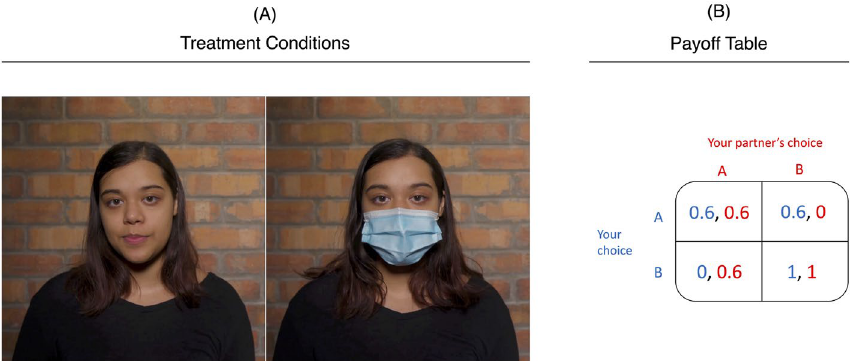
Figure 1. Experimental setup. Note : ( A ) shows a video snapshot of the two randomized treatment conditions; ( B ) shows the payoff matrix for the game where the first value in each cell represents the payoff in US dollars the participant receives, conditional on the opponent’s